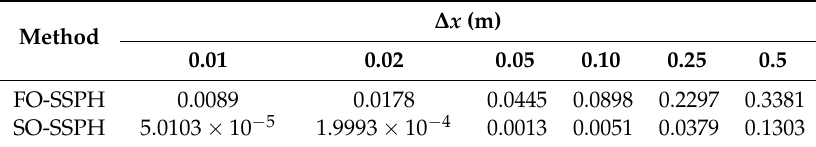
Table 1. Errors of FO-SSPH and SO-SSPH for one-dimensional heat conduction with discontinuous initial distribution.